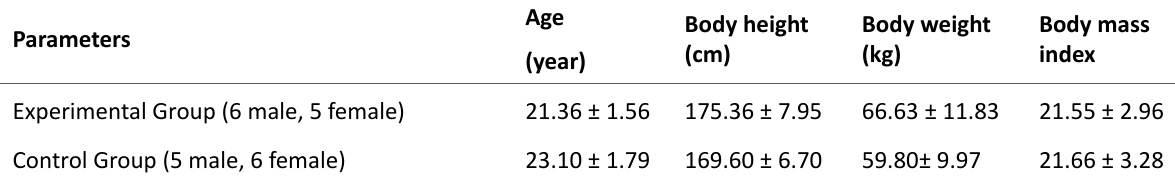
Table 1. Demographic information of the